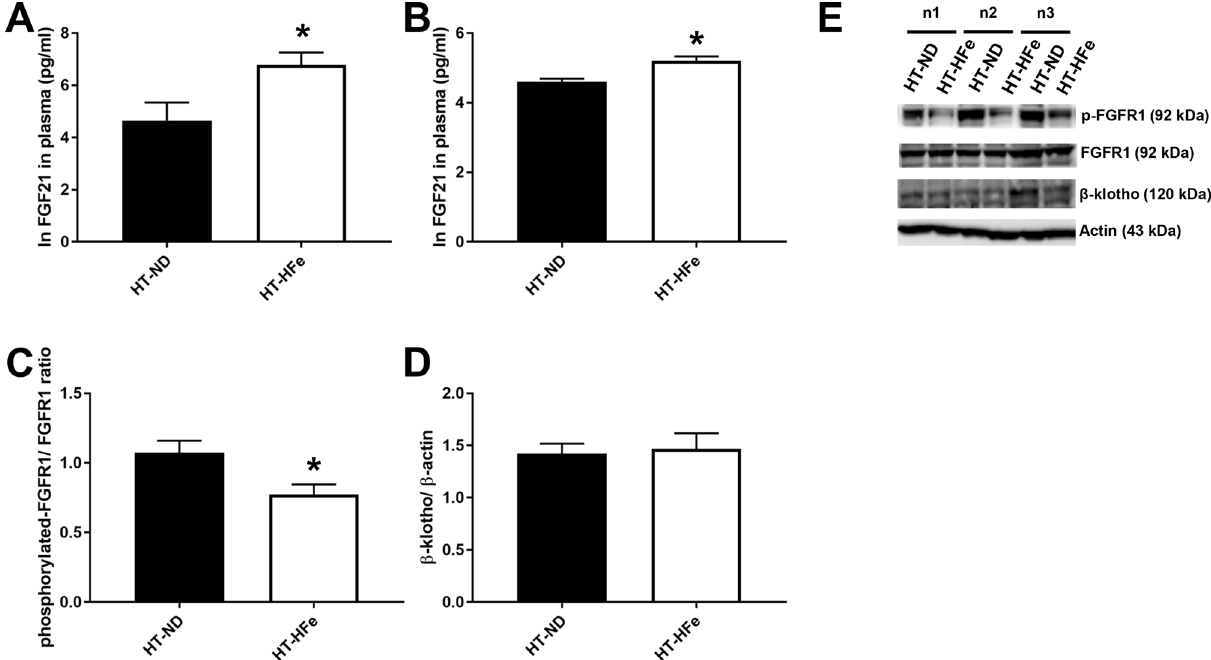
Figure 2. Plasma FGF21 level in plasma ( A ), brain FGF21 level ( B ), and brain FGF21 signaling cascades including a ratio of phosphorylated-FGFR1/FGFR1 ( C ) and β-klotho/actin ( D ) of β-thalassemic mice fed with either normal diet or high-iron diet. Three replicates of cropped representative bands for brain FGF21 signaling proteins are shown ( E ). In addition, full-length blots are presented in Supplementary Fig. 1. The samples derive from the same experiment and that gels/blots were processed in parallel. Actin was used as a loading control and the density of detected protein was divided by the density of actin from the sample. FGF21 fibroblast